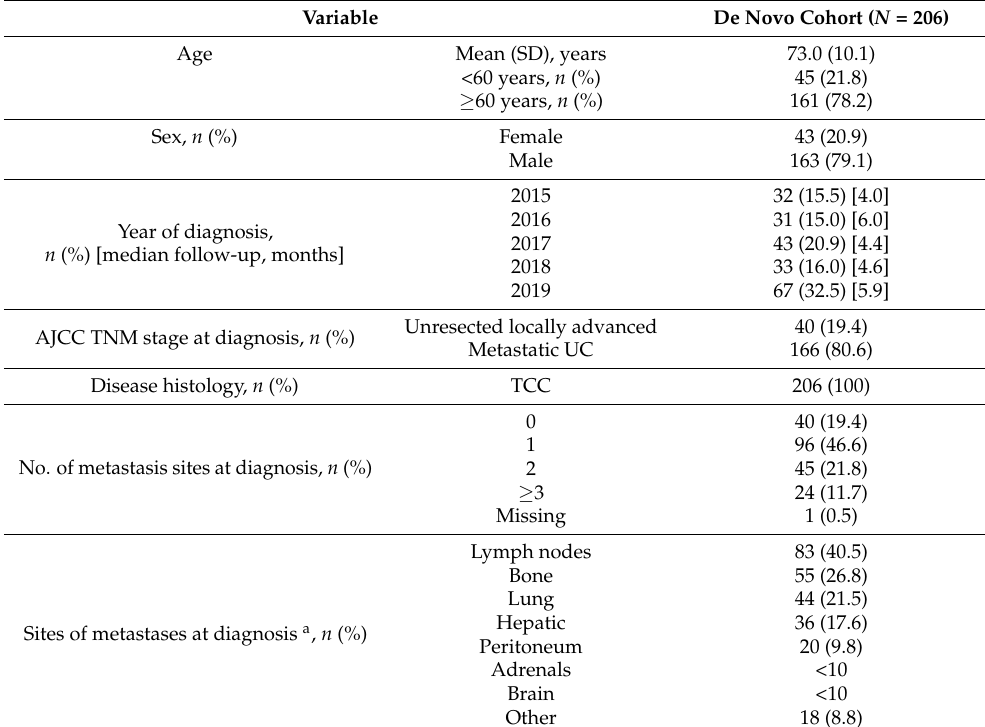
Table 1. Baseline characteristics of patients with de novo la/mUC.